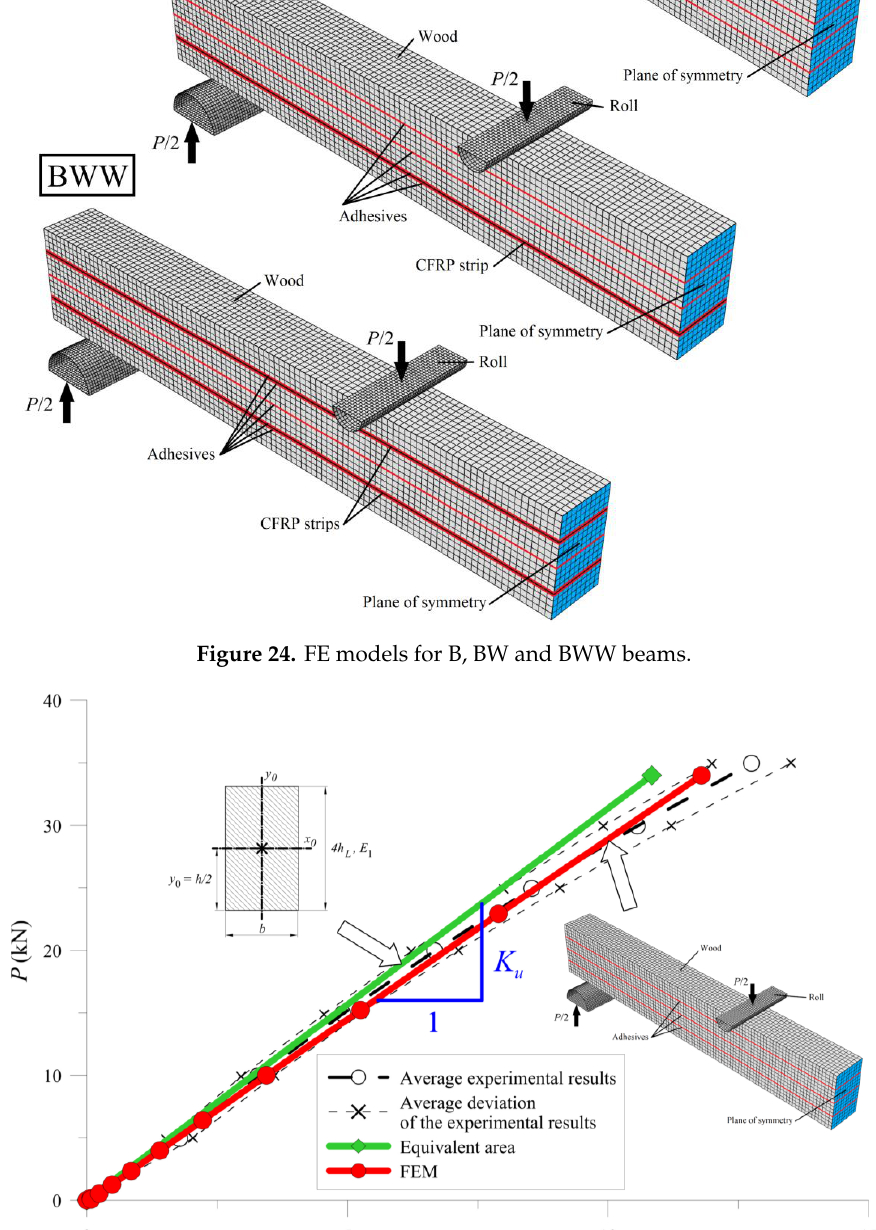
Figure 25. Results for B-type of the sample.